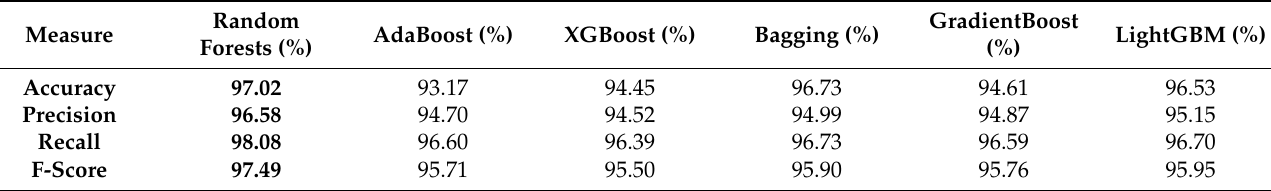
Table 2. Performance of ensemble classifiers for Dataset 1.